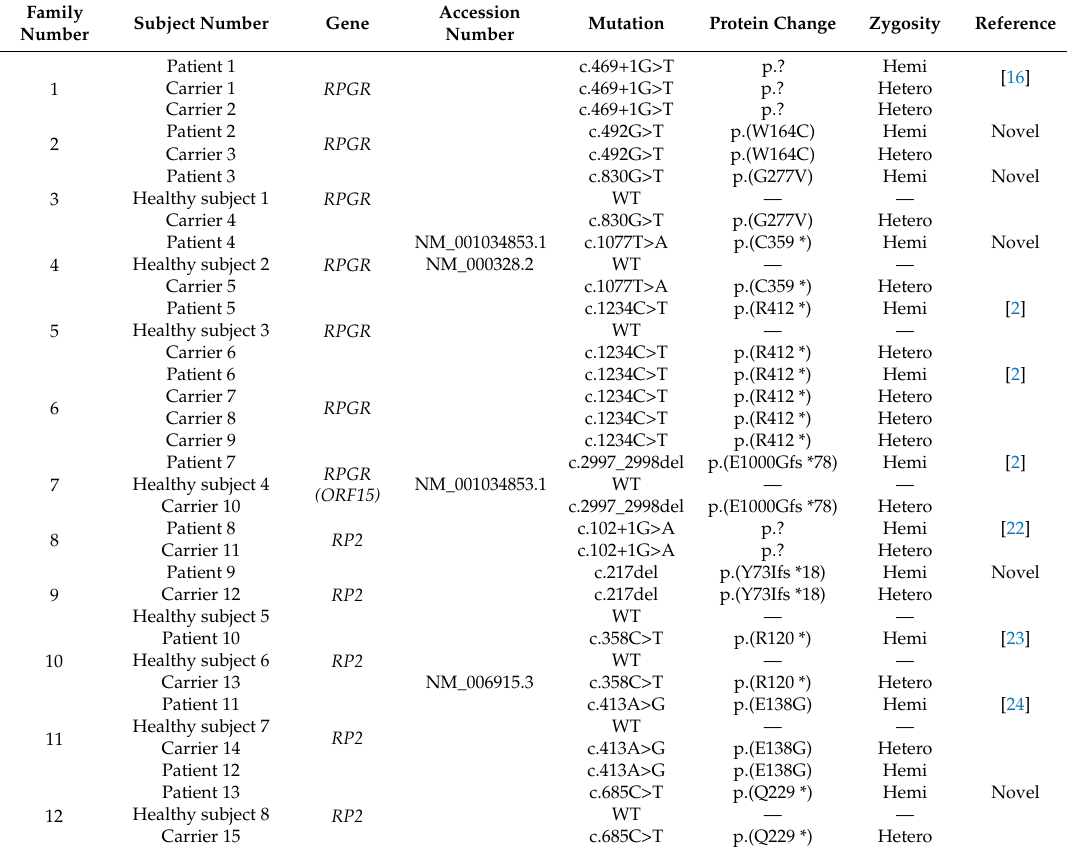
Table 1. Mutations found in RPGR or RP2 in subjects in the present